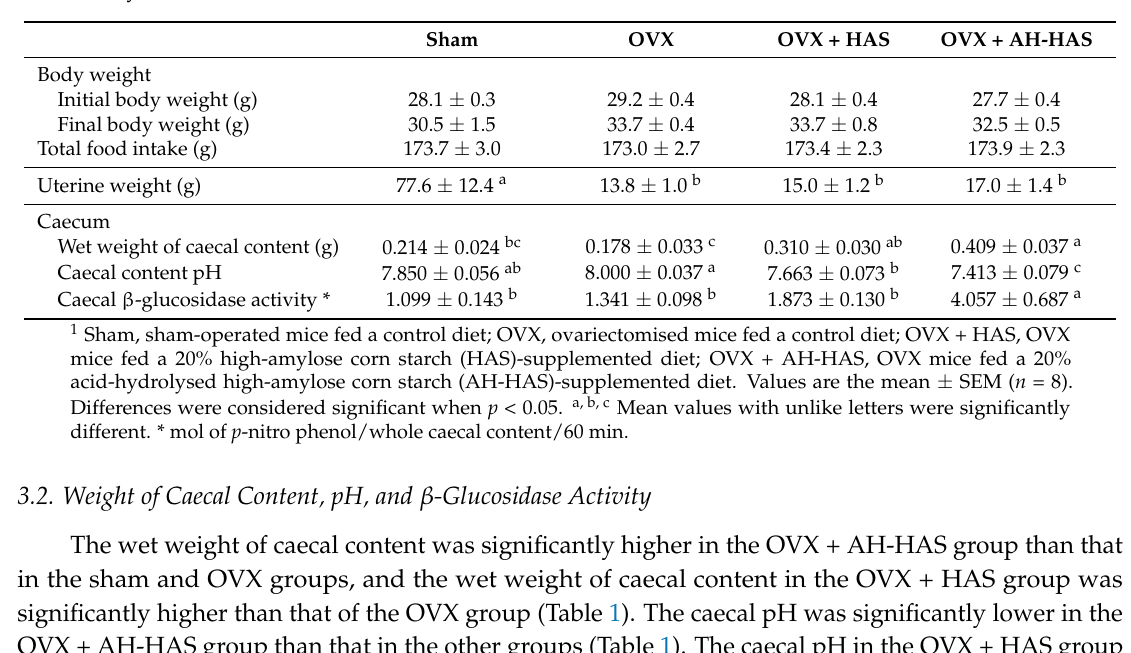
Table 1. Body weight, food intake, wet weight of caecal content, pH and β -glucosidase activity in mice on day